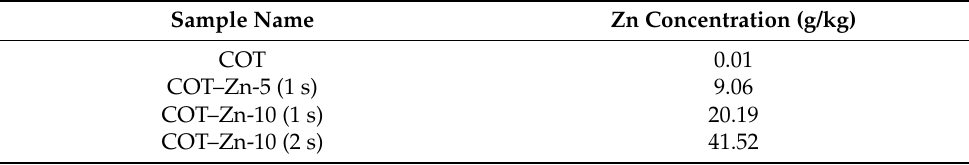
Table 4. Results of determination of zinc content in COT–Zn composite samples.